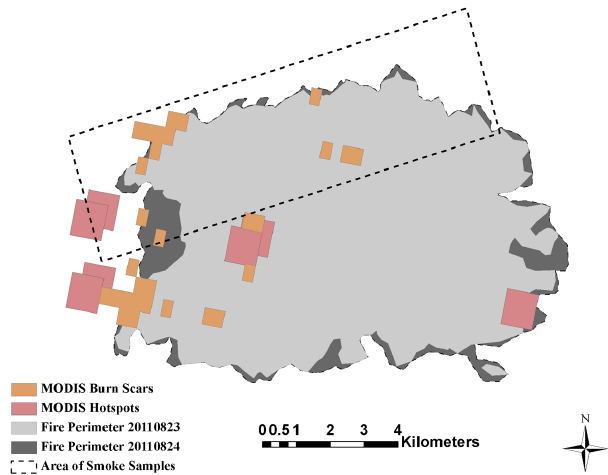
Fig. 1. Region of smoke sampling, fire perimeters, and area of active burning for Saddle Complex on 24 August 2011. The MODIS active fire detections and MODIS burn scars are from 24 August